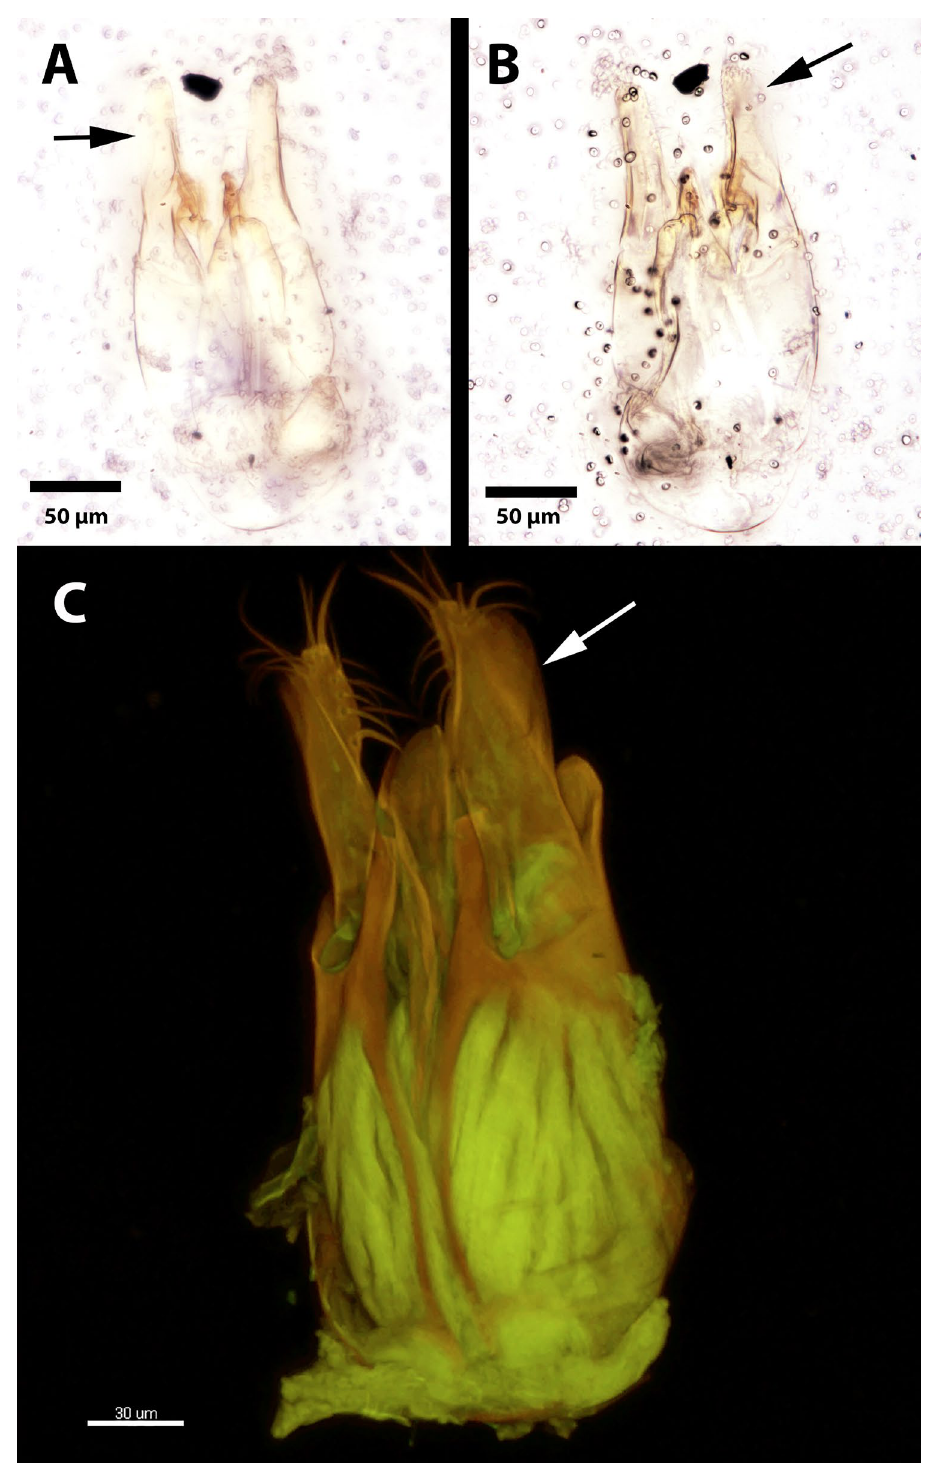
Fig. 4. Ceraphron mymecophilus kieffer, 1913, synonymized with Aphanogmus abdominalis (Thomson, 1858). A–B . Syntype, ♂ (MNHN EY22464). Genitalia. A . Dorsal view. B . Ventral view. C . CLSM image showing the male genitalia of a different specimen (PSUCIM_3120), ventral view. Volume rendered media file available at https://doi.org/10.6084/m9.figshare.100875.v2. Arrows point to the cuticular fold on the ventral edge of the harpe that is characteristic of Aphanogmus abdominalis (Thomson,